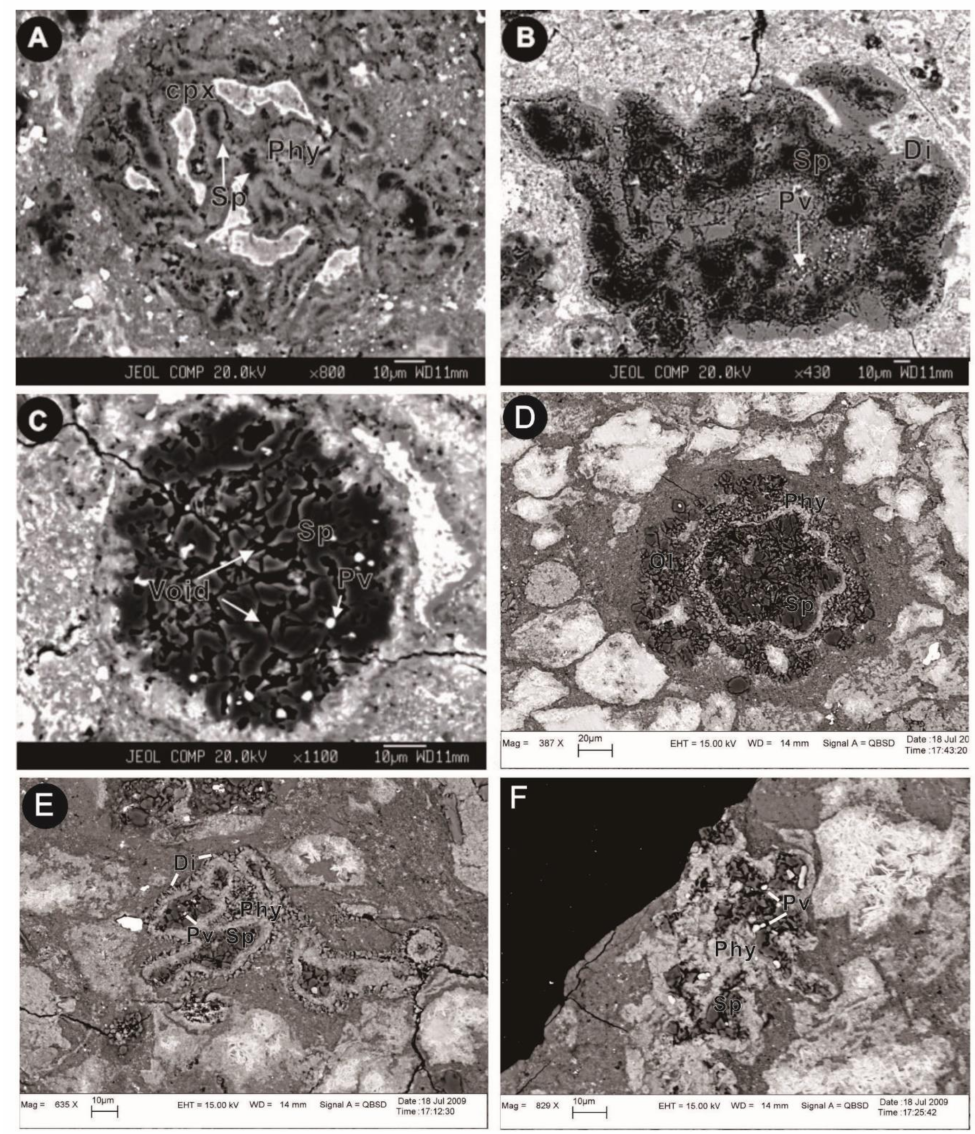
Figure 2. Backscattered electron images of refractory inclusions in GRV 020025 and GRV 050179; ( A – C ) reproduced from reference [13]: ( A , B ) type A-like inclusions; c: spinel spherule. ( C – F ) type A-like inclusions. Sp: spinel; Di: diopside; Ol: olivine; Pv: perovskite; Phy: phyllosilicate; cpx: